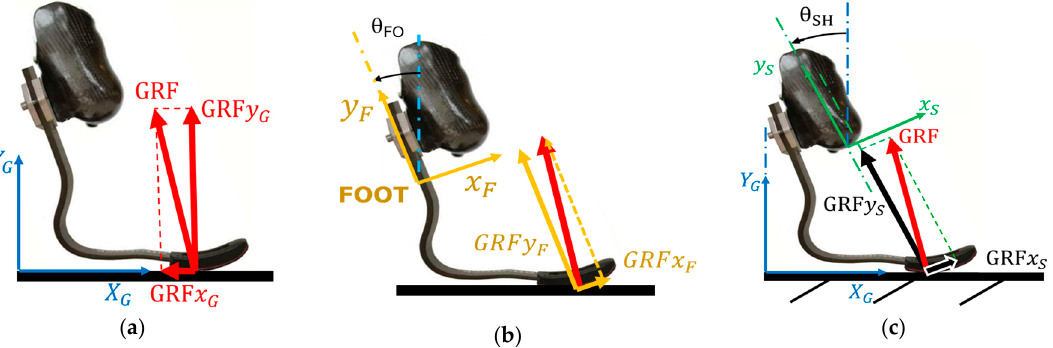
Figure 1. Reference Frames adopted to express the Ground Reaction Forces (GRF) components ( a ) Global Reference Frame and GRF components, ( b ) Foot reference frame and GRF components, ( c ) Socket reference frame and GRF